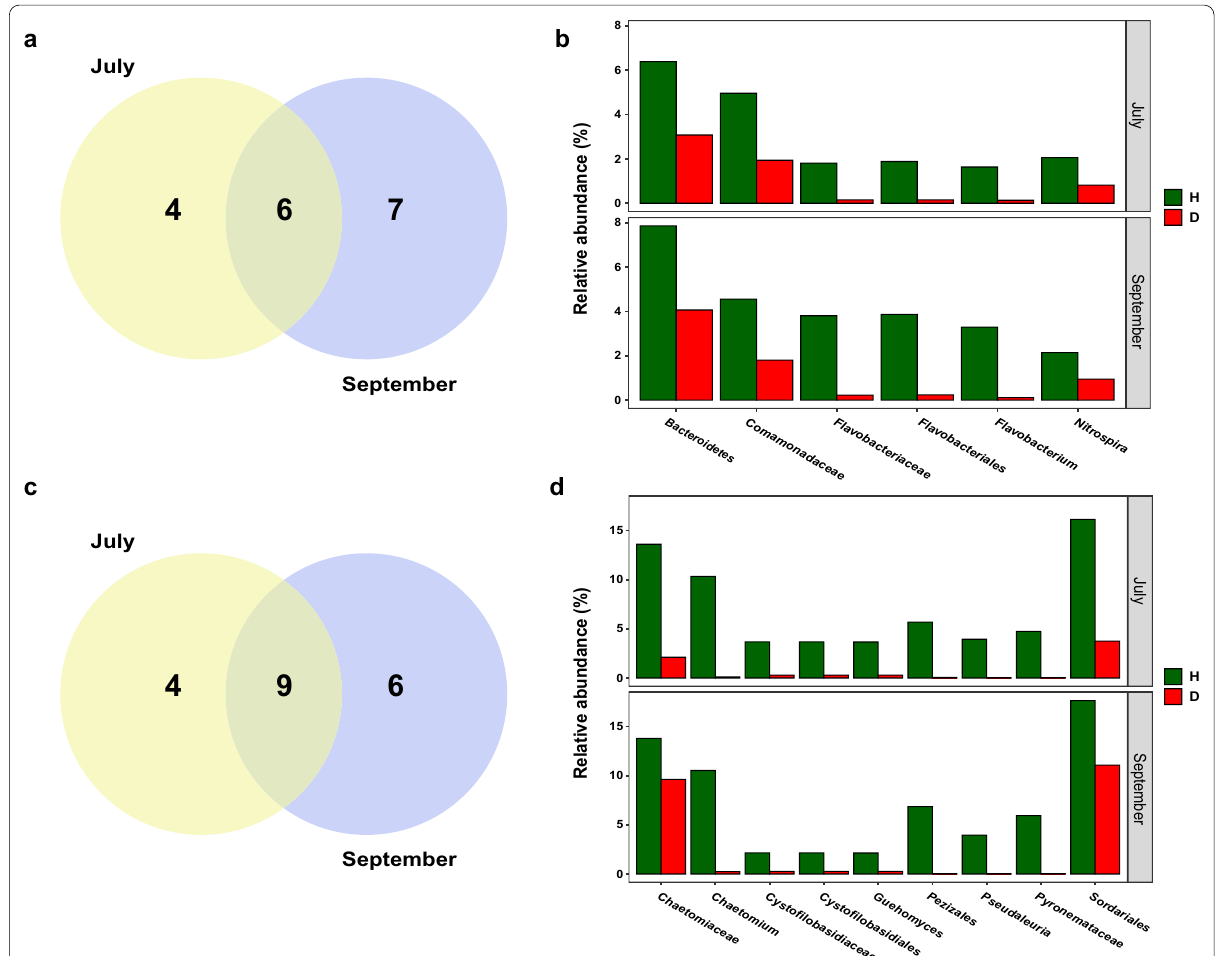
Fig. 4 Venn diagram showing the number of discriminative bacterial ( a ) and fungal ( c ) taxa in healthy soils and histogram showing relative abundance of shared bacterial ( b ) and fungal ( d ) taxa in both healthy (H) and diseased (D)